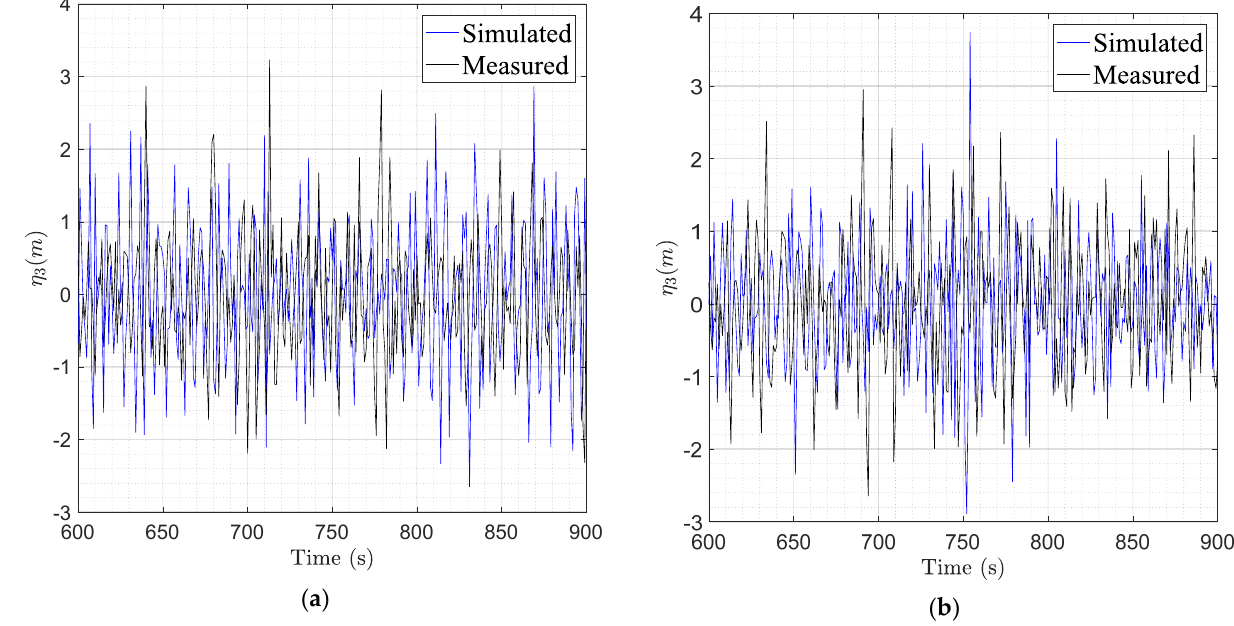
Figure 8. Heave time series comparison: ( a ) 7 January 2020; ( b ) 8 January 2020.